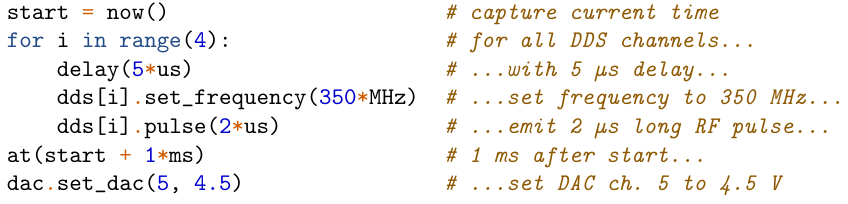
Figure 32. Fragment of the experiment described in ARTIQ DSL.